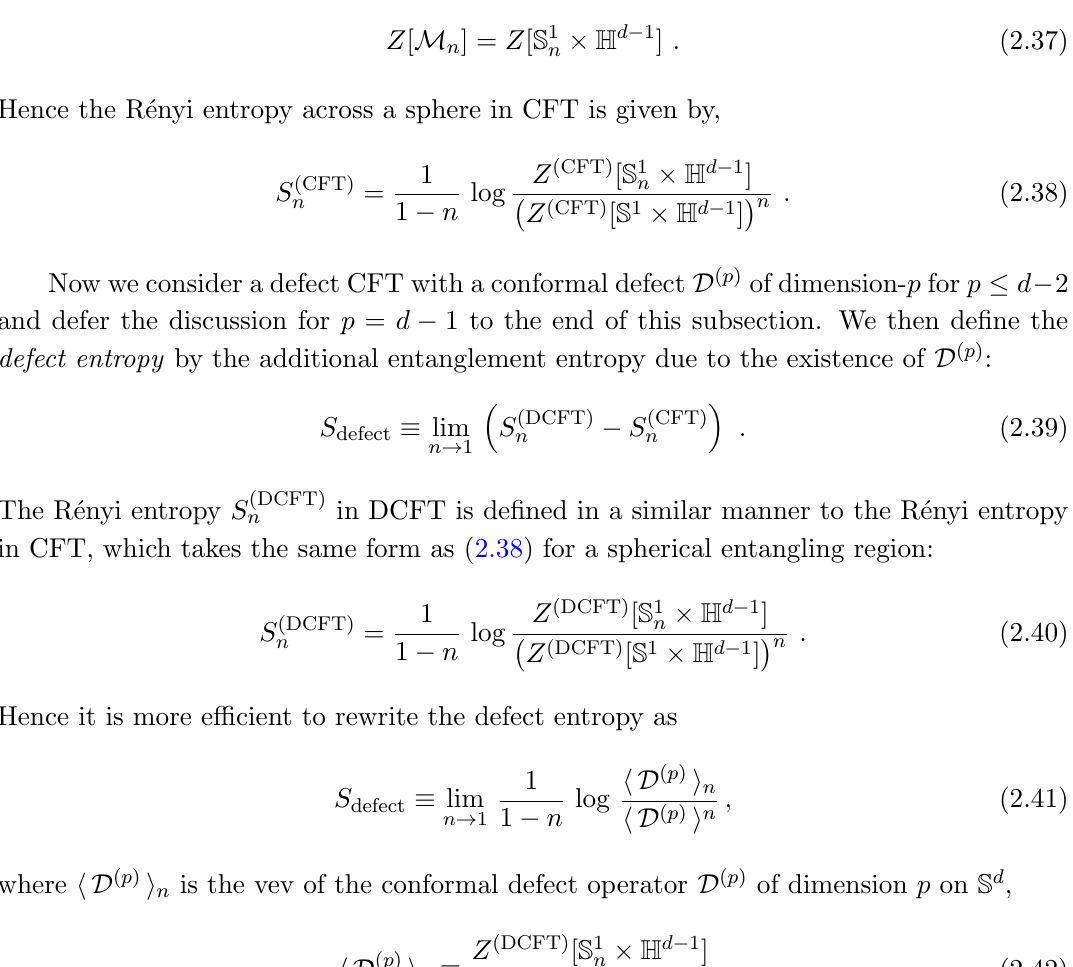
Figure 2 . The locations of the entanglement surface (cid:6) and the conformal defect D ( p ) in the hyperbolic coordinates (2.31). The hyperbolic space H p (cid:0) 1 is (cid:12)bered on each point of the base. with the range 0 (cid:20) (cid:28) < 2 (cid:25) . If there are no conformal anomalies, the partition function is invariant under the conformal